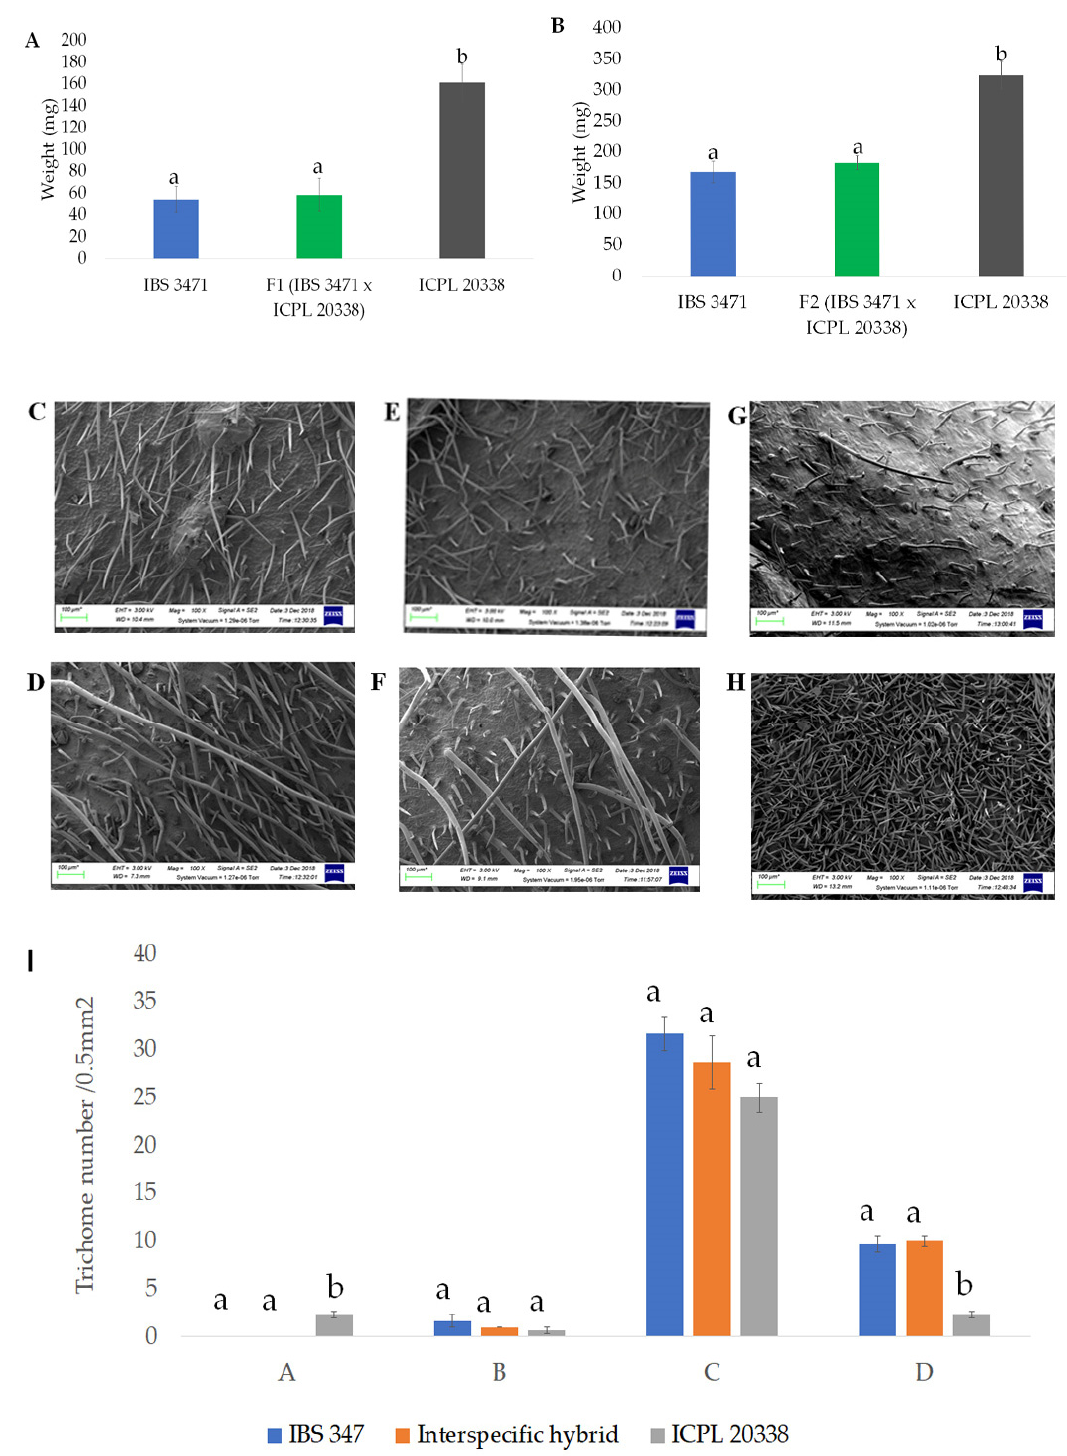
Figure 6. Insect-feeding bioassays, using intact detached leaves and an artificial diet supplemented with lyophilised leaf powder and scanning electron micrographs of trichomes of interspecific hybrid and its parents. ( A ) Average larval weight (mg) of neonate H. armigera larvae fed on F 1 interspecific hybrid and its parents intact detached leaves by day eight. ( B ) Average larval weight (mg) of neonate H. armigera larvae fed on an artificial diet supplemented with lyophilised leaf powder of F 2 interspecific hybrid and its parents by day five. ( C – H ) Scanning electron micrographs of trichomes on the F 2 interspecific hybrid and its parents at 100X magnification (scale bars = 100 µ m), ( C ) IBS 3471 leaf, ( D ) IBS 3471 pod, ( E ) F 2 interspecific hybrid leaf, ( F ) F 2 interspecific hybrid pod, ( G ) ICPL 20338 leaf, ( H